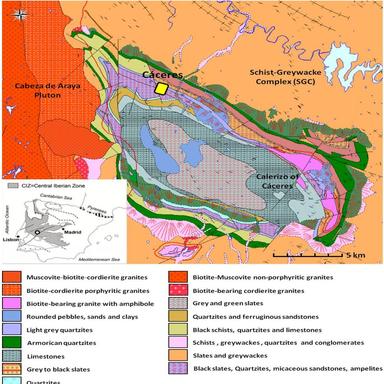
Geological scheme of the Cáceres area (obtained from GEODE, http://info.igme.es/visorweb/, continuous digital geological map of Spain, scale 1:50.000)